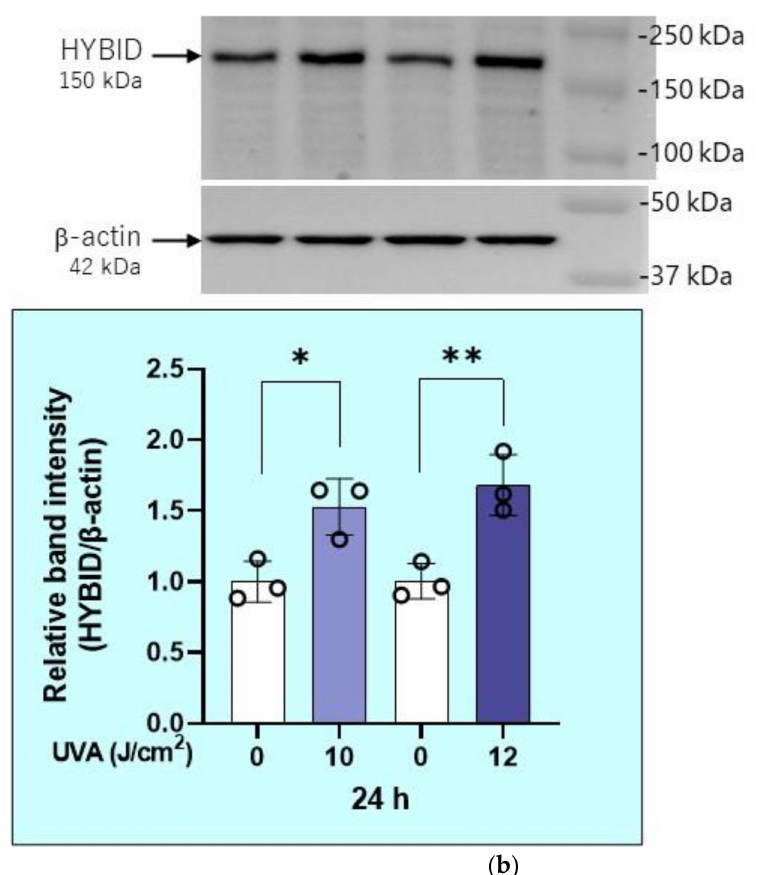
Figure 6. Effects of UVA on mRNA ( a ) and protein ( b ) levels of Hyaluronan Binding protein Involved in HA Depolymerization (HYBID). After exposure to UVA at 0, 10, or 12 J/cm 2 , HDFs were cultured in DMEM without FBS. Cell lysates obtained at the indicated times of culture were subjected to RT-qPCR and western blotting analysis as described in the Materials and Methods section. Values are means ± S.D. from four ( a ) and three ( b ) independent experiments. **: p < 0.01 vs. 0 J/cm 2 , *: p < 0.05 vs. 0 J/cm 2